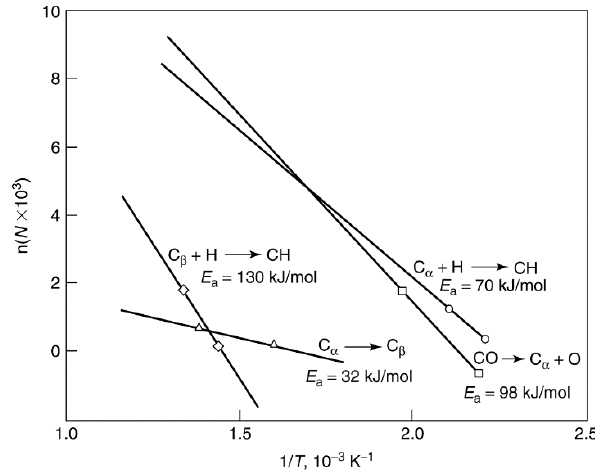
Figure 14. Rates of formation (log scale) and hydrogenation of C α and C β versus reciprocal temperature. Reproduced from [60]. Copyright 1983,